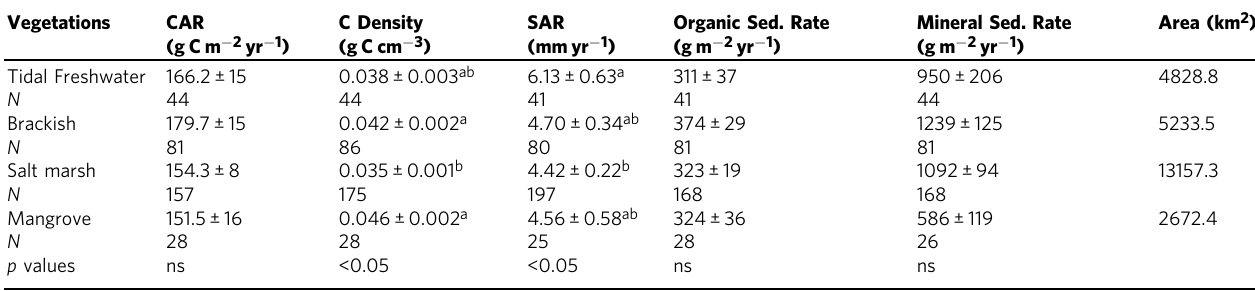
Table 2 Conterminous United States tidal wetland sediment characteristics and area among different vegetation types (mean ± s.e.m.).